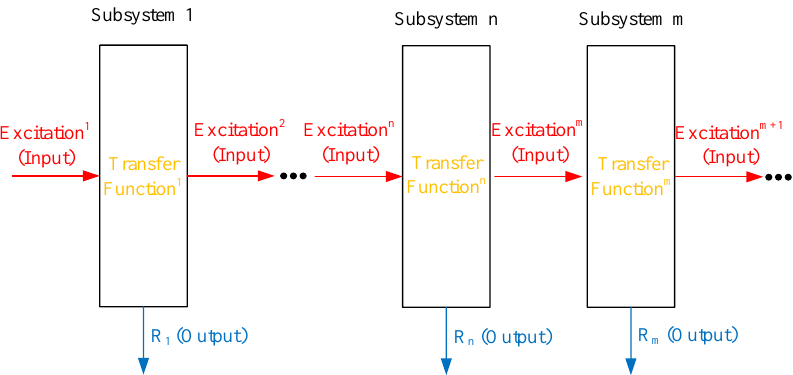
Figure 1. The complex systems with multiple subsystems.